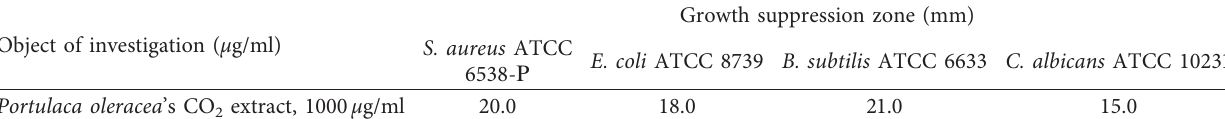
2 extract obtained by the disco-diffuse method.